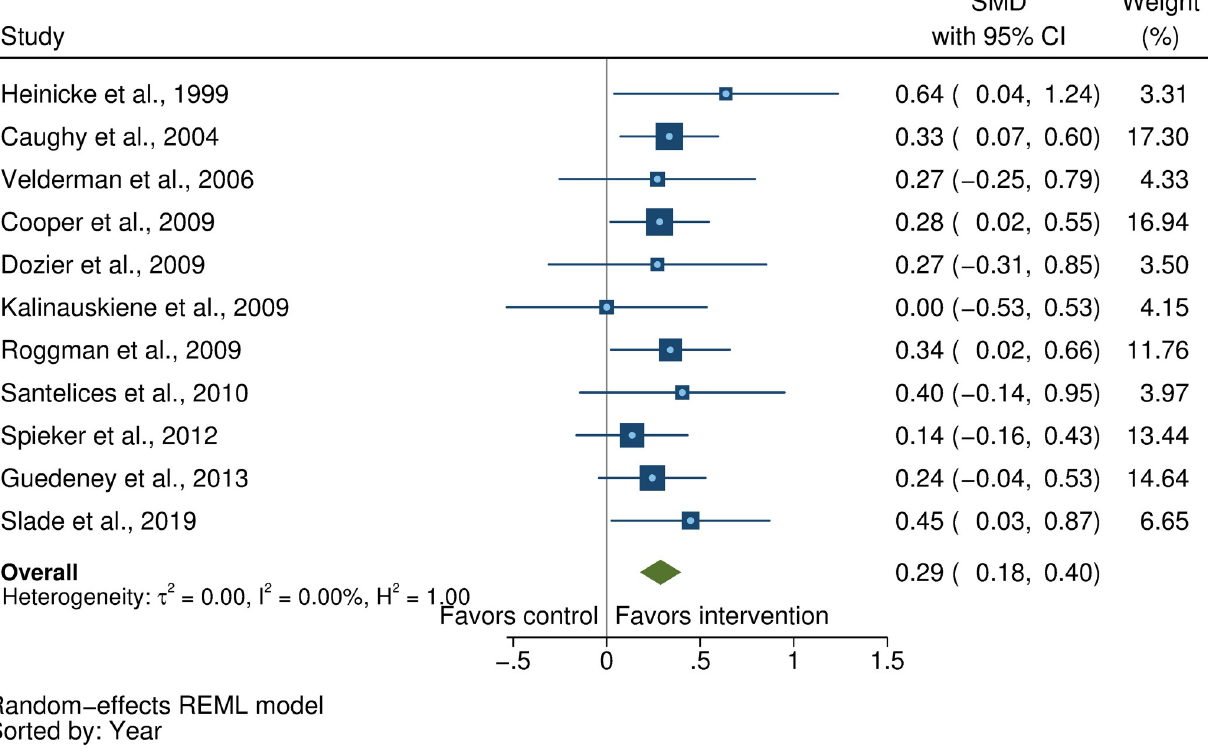
Fig 7. Forest plot for the effect of parenting interventions on attachment. Blue squares represent the SMD for each study, with the size of the square being proportional to the study weight. The whiskers extending from each side of the square represent the range of the 95% CI. The green diamond shows the overall pooled effect size using a random-effects model, which is centered at the point estimate and the diamond width representing the 95% CI. SMD, standardized mean